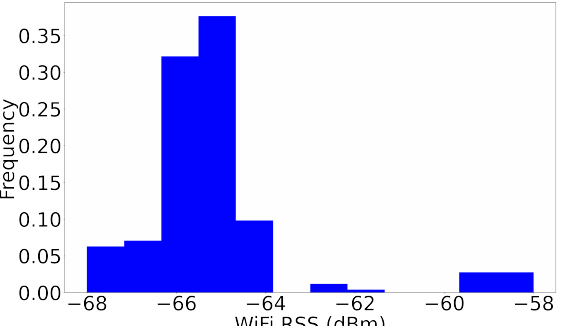
Figure 7. A histogram of the WiFi RSS signal measurement from the dataset proposed in Section 5.1. We observed that the RSS measures were unstable and easily attenuated during long observation period.